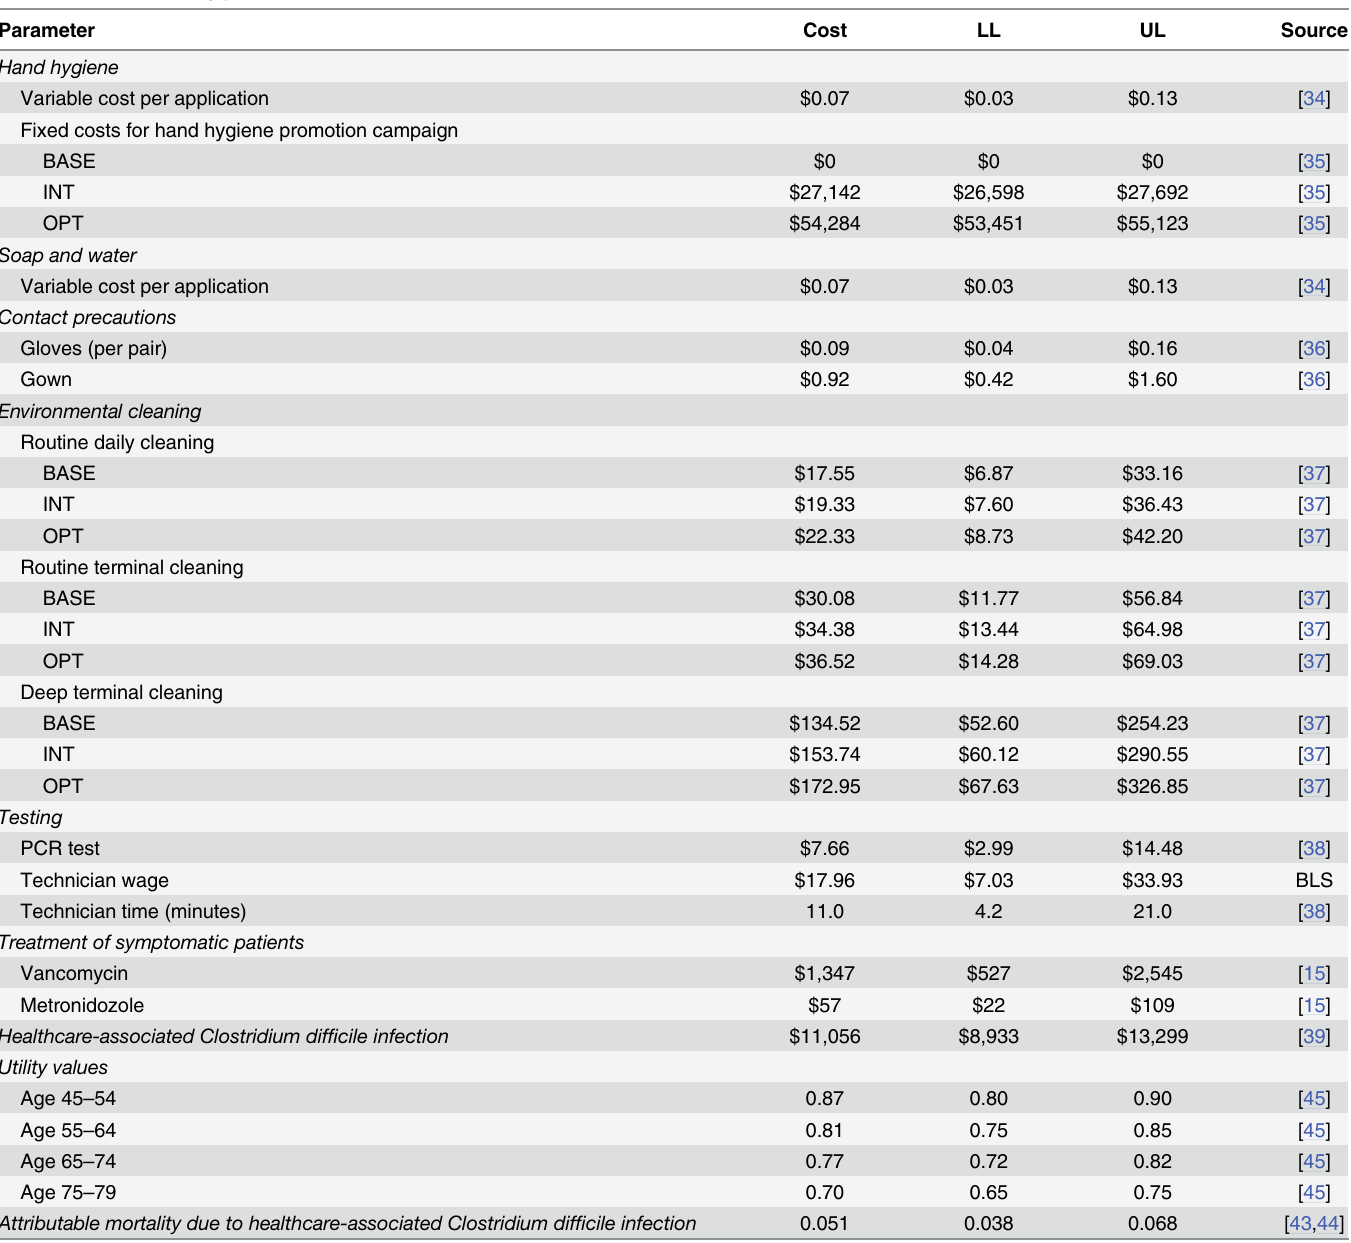
Table 2. Cost and utility